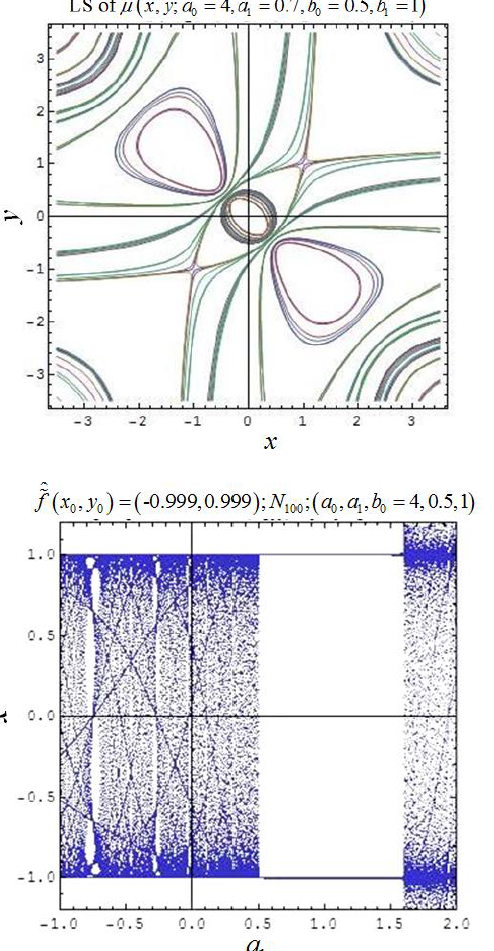
= 4 (up). Bifurcation situation 0